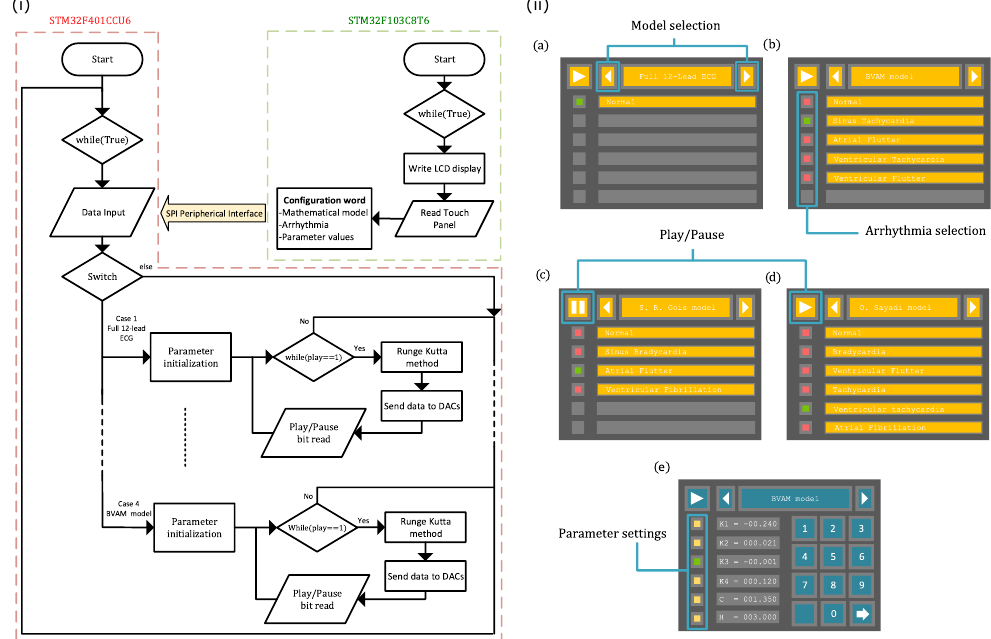
Figure 2. ( i ) Flowchart of the ECG patient simulator for both microcontrollers, STM32F401CCU6 and STM32F103C8T6. ( ii ) Graphical user interface, where different screens to interact with the user were implemented: ( a ) model selection, ( b ) arrhythmia selection, ( c , d ) play/pause generation of ECG waveforms, and ( e ) parameter